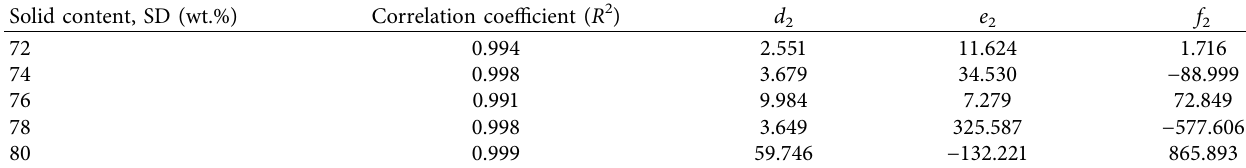
Table 12: Viscosity fitting results of CUTB samples under various c/t ratios. Solid content, SD (wt.%)